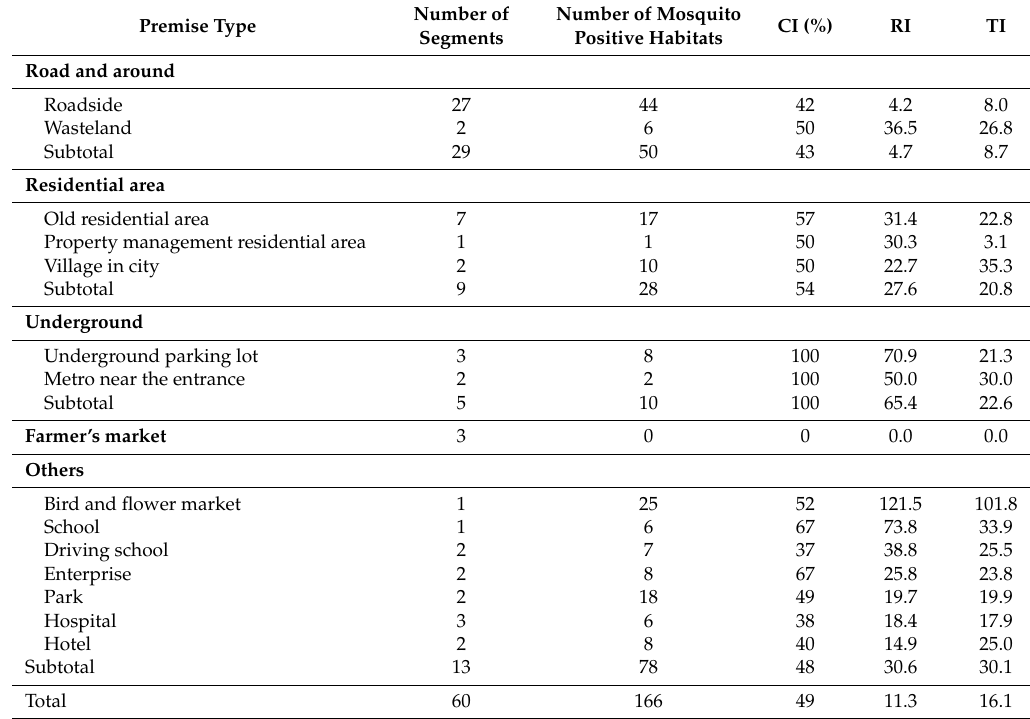
Table 2. Number of inspection route segments, number of mosquito-positive habitats, and larval indices in Guangzhou, by premises